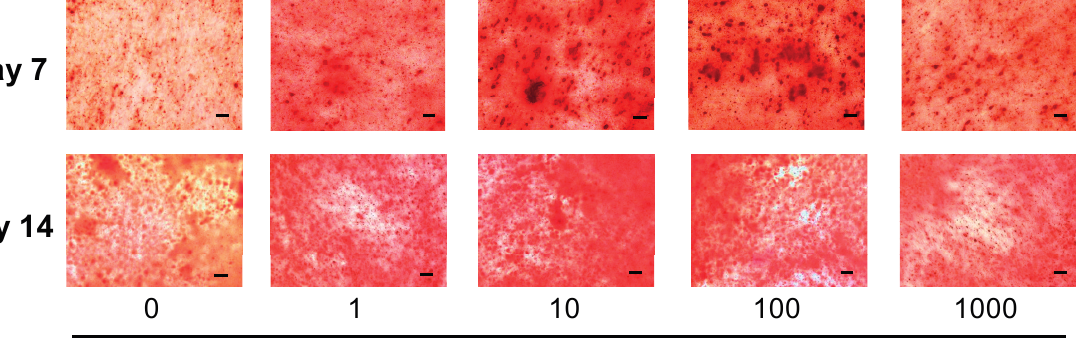
Figure 4. Effect of SP on mineralization. ( A ) Confluent MSCs were stained with Alizarin Red after 7 or 14 days of cultivation in osteogenic medium containing SP (0, 1, 10, 100 or 1000 ng/mL). Scale bar = 100 μ m; ( B , C ) The extracellular calcium deposition was measured at 7 or 14 days. ( B ) day 7, * p < 0.05, vs. SP (0 ng/mL); ( C ) day 14, * p < 0.05, vs. SP (0